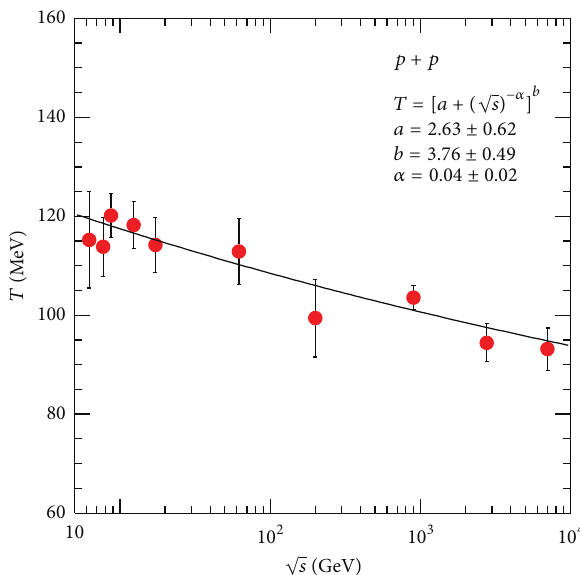
Figure5:Theinvariantyieldspectraof (𝜋 + +𝜋 − )/2 [21],asafunction of 𝑚 𝑇 − 𝑚 for 𝑝 + 𝑝 collisions at √𝑠 = 900 GeV. The yields are shown ⟩ 7, 16, 28, 40, 52, 63, and 75. The spectra are scaled up for for ⟨𝑁 tracks clarity by a factor of 6 𝑖 , where 𝑖 = 0, 1, 2, 3,4, 5 , and 6. The solid lines show the Tsallis